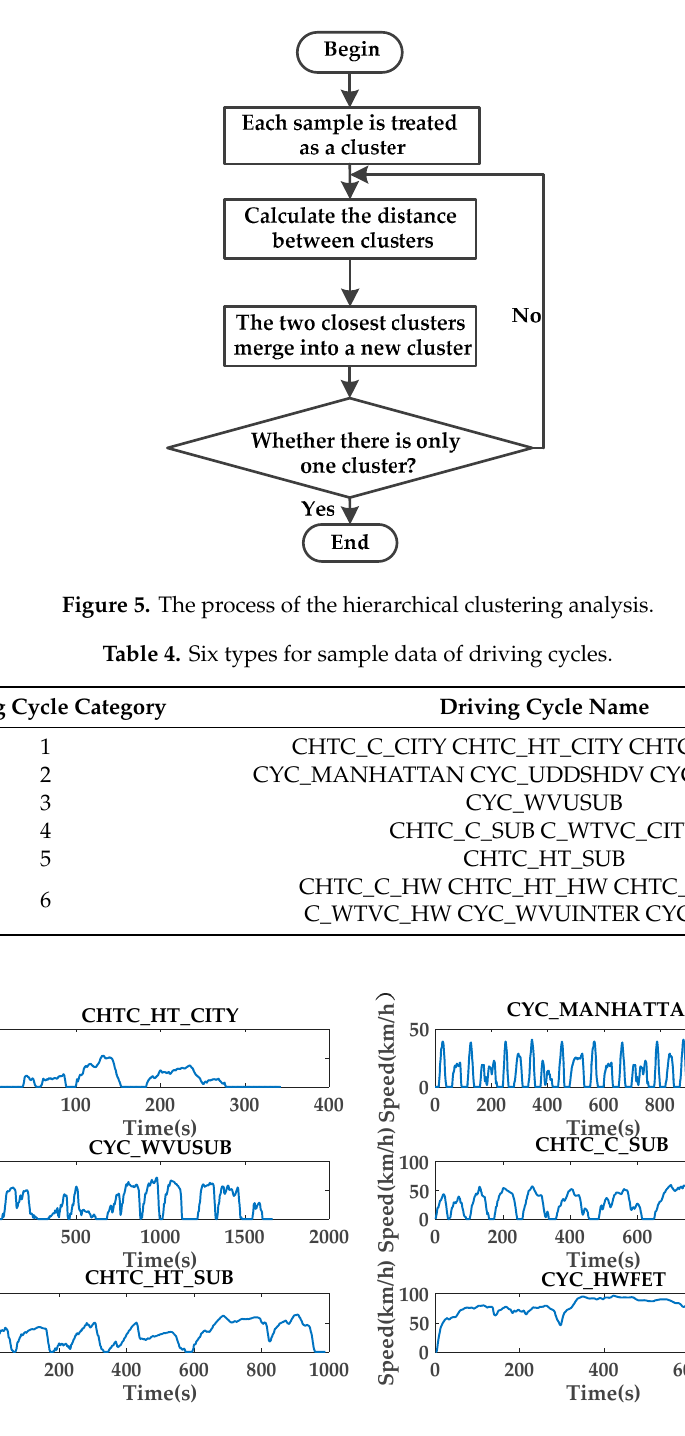
Figure 6. Curves of six typical driving cycle.